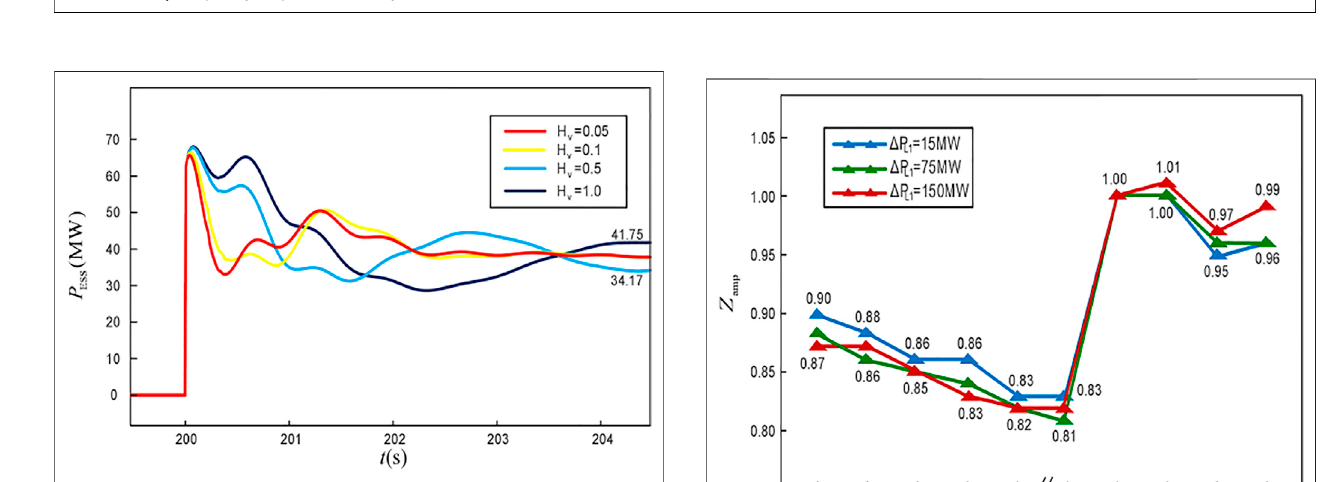
FIGURE 11 | Frequency response of the system for different H v .